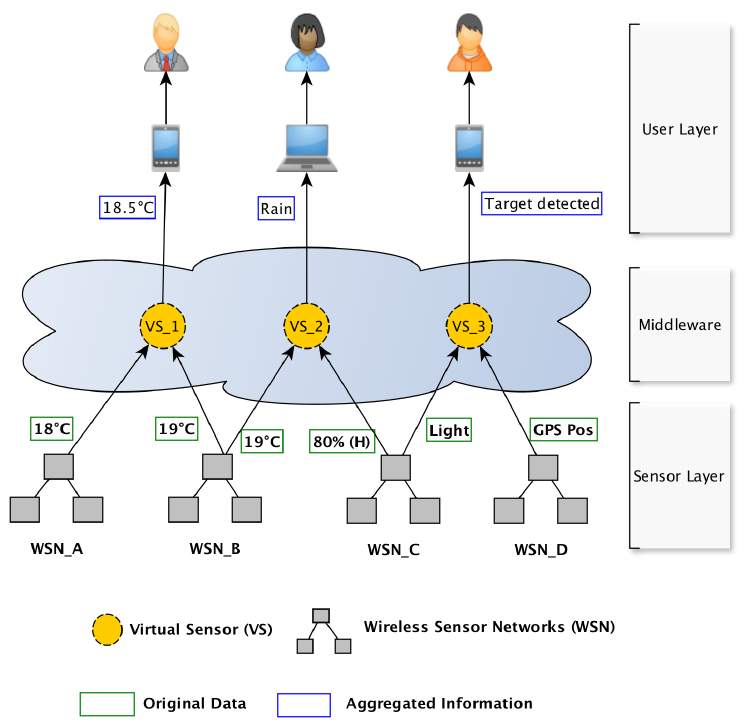
Figure 1. Conceptual model of a sensor